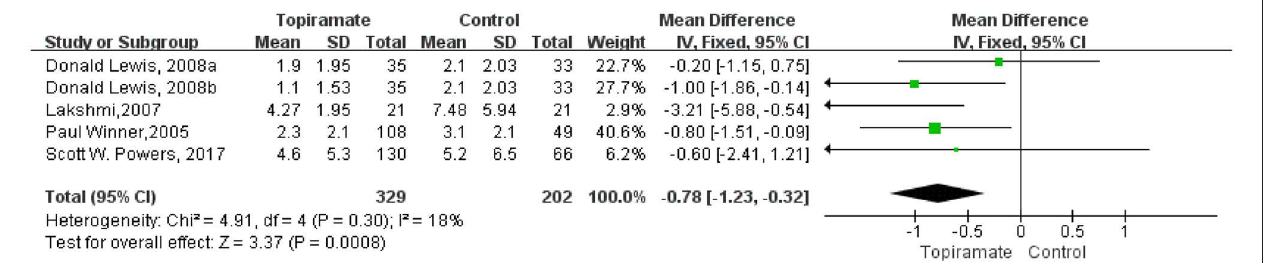
Frontiers in Pediatrics |